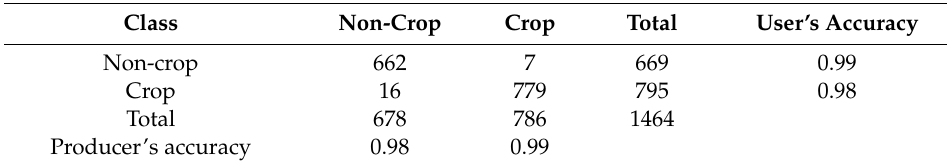
Table 3. Results of the segment based cropland vs. non-cropland classification for Barisal division in the spring of 2019.